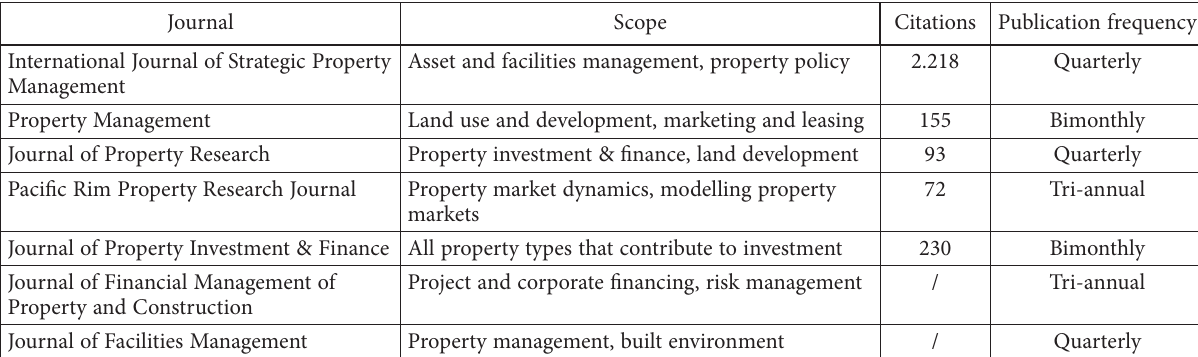
Table 1. Comparison among the IJSPM and other similar